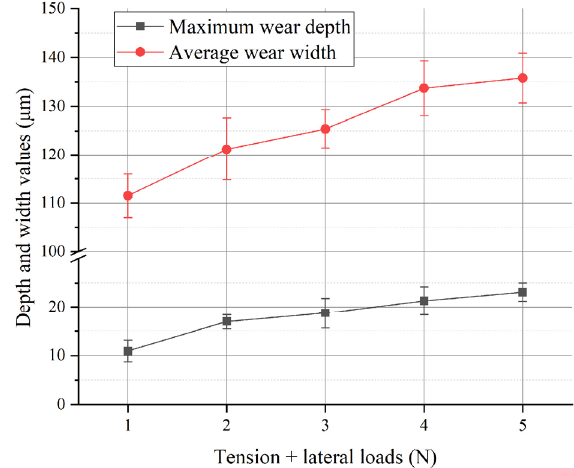
Fig. 19 Maximum wear depths and average wear widths of center steel wire under different loading conditions. (1: 120 N + 80 N, 2: 120 N + 160 N, 3: 120 N + 240 N, 4: 150 N + 240 N, and 5: 180 N + 240 N).